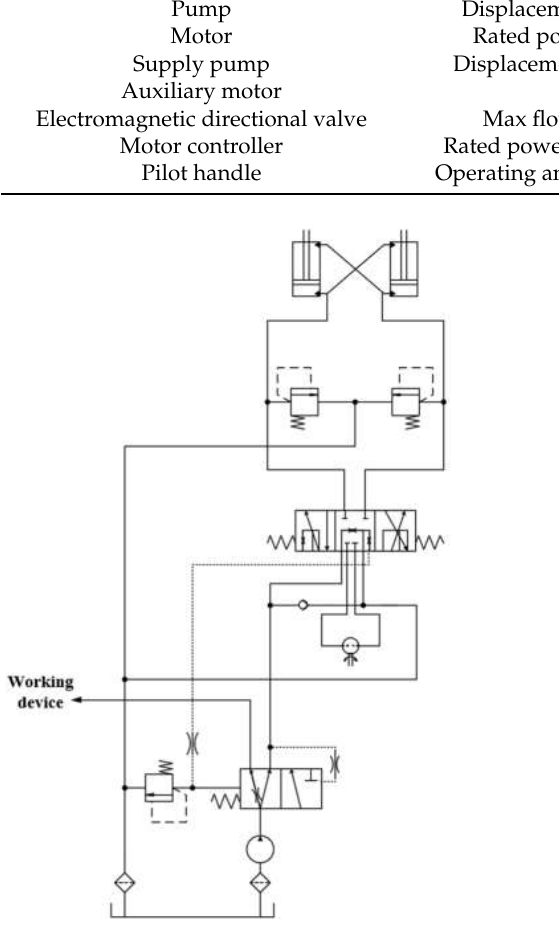
Figure 8. Hydraulic schematic diagram of traditional full hydraulic steering system.